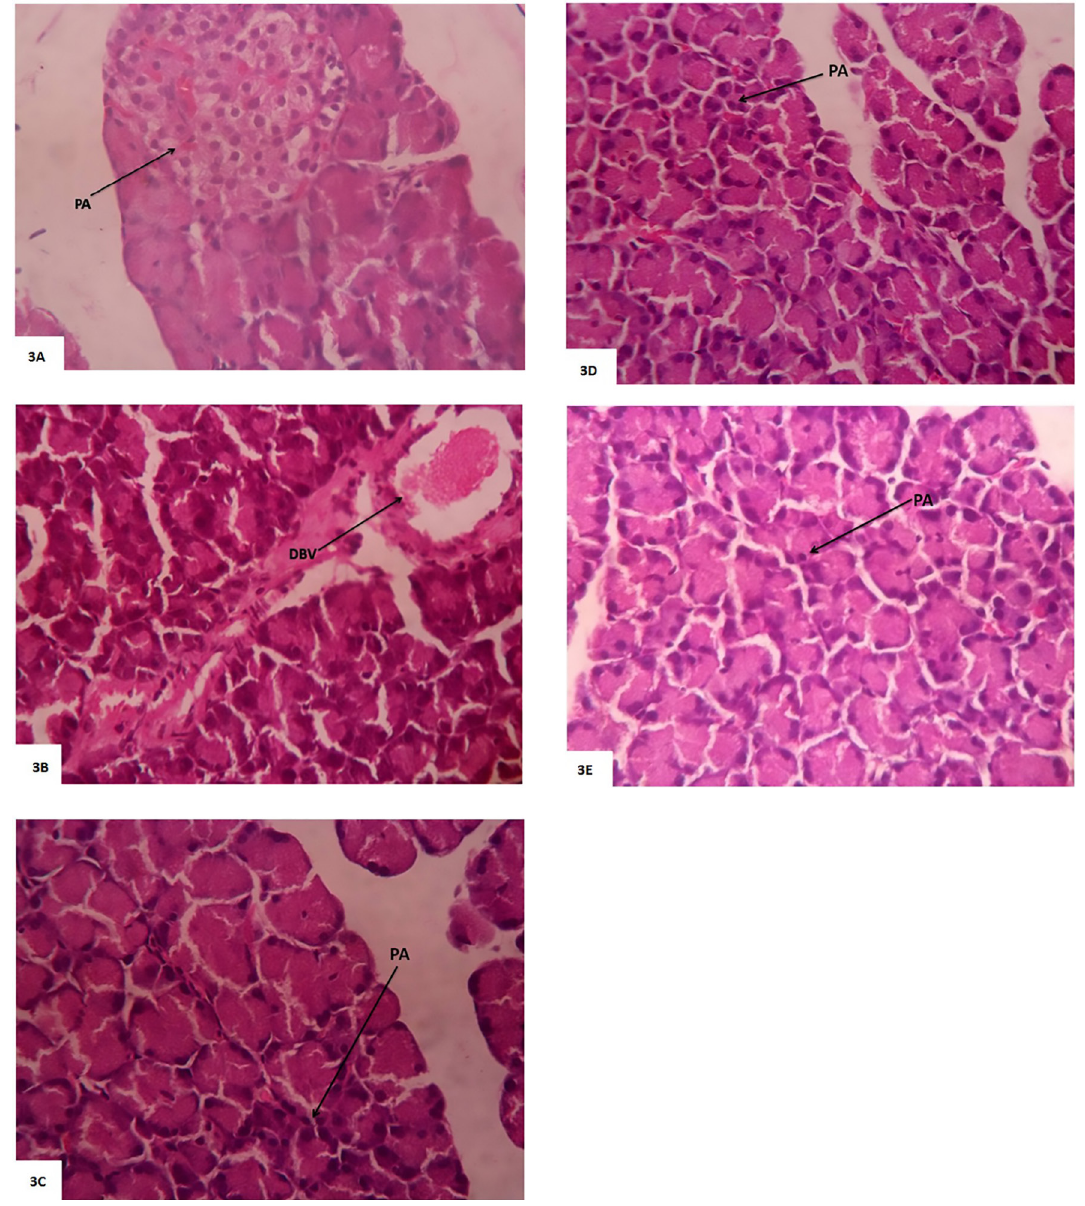
extract (200 mg/kg). PA-Pancreatic acini; DBV- Dilated blood